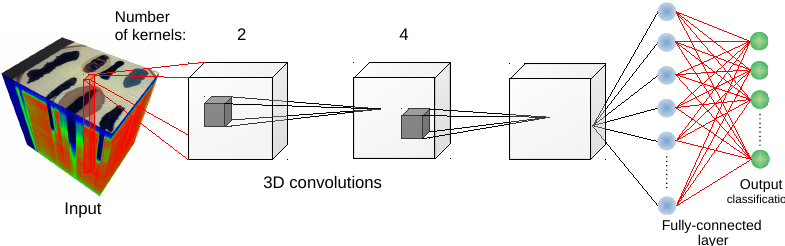
Figure 6. Schematic of the 3D CNN architecture [11] used in experiments.